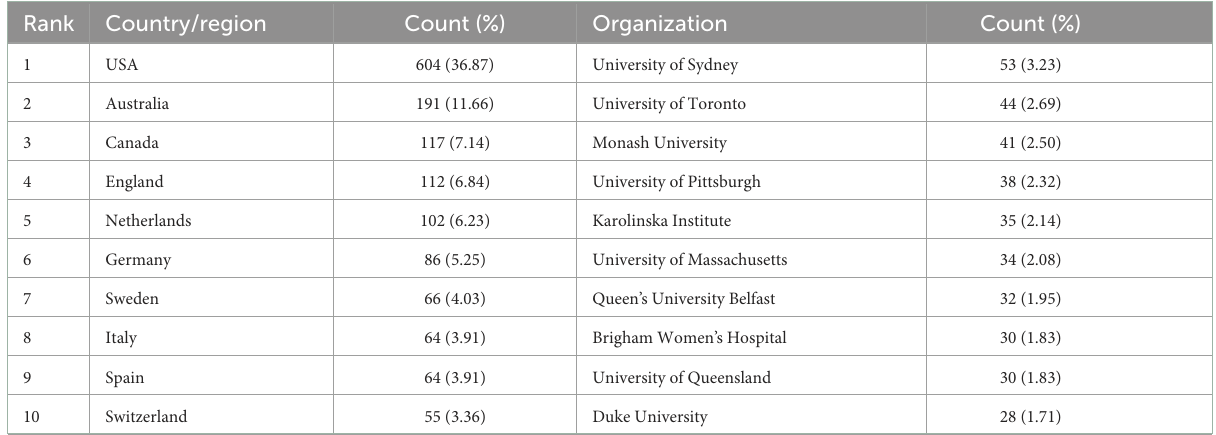
TABLE 2 Top 10 countries/regions and organizations in terms of publications from 2000 to 2021.